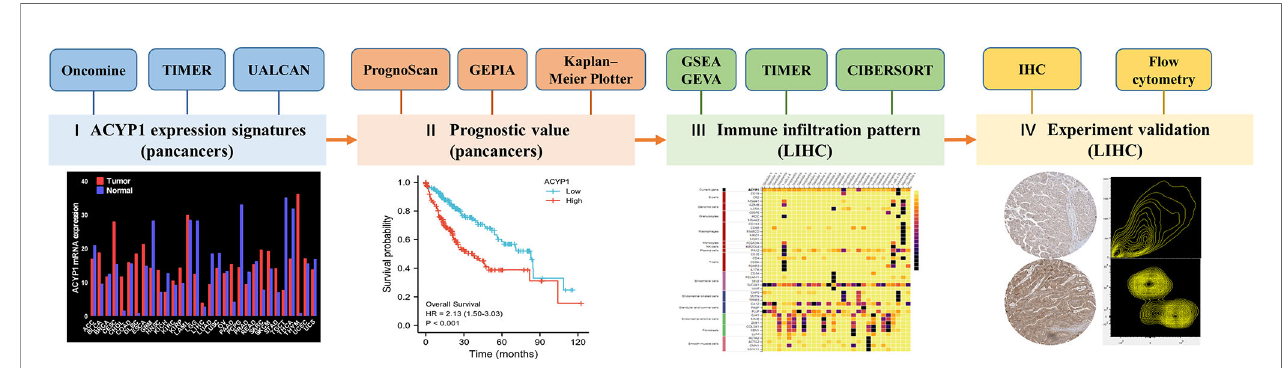
FIGURE 7 | Study fl ow-chart. I ACYP1 expression patterns explored via Oncomine, TIMER, and UALCAN; II Survival analysis of ACYP1 in PrognoScan, Kaplan — Meier Plotter, and GEPIA; III Signaling pathways and TME affected by ACYP1 via GSEA, GSVA, and TIMER; IV Experimental validation in human and mice tumor samples